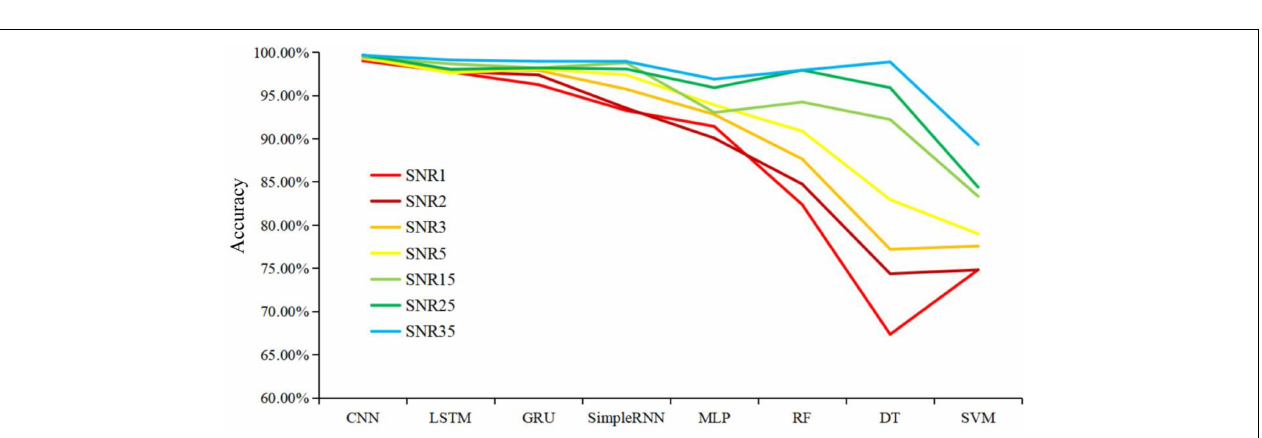
outliers, which is able to solve the problem (Cabana et al.,